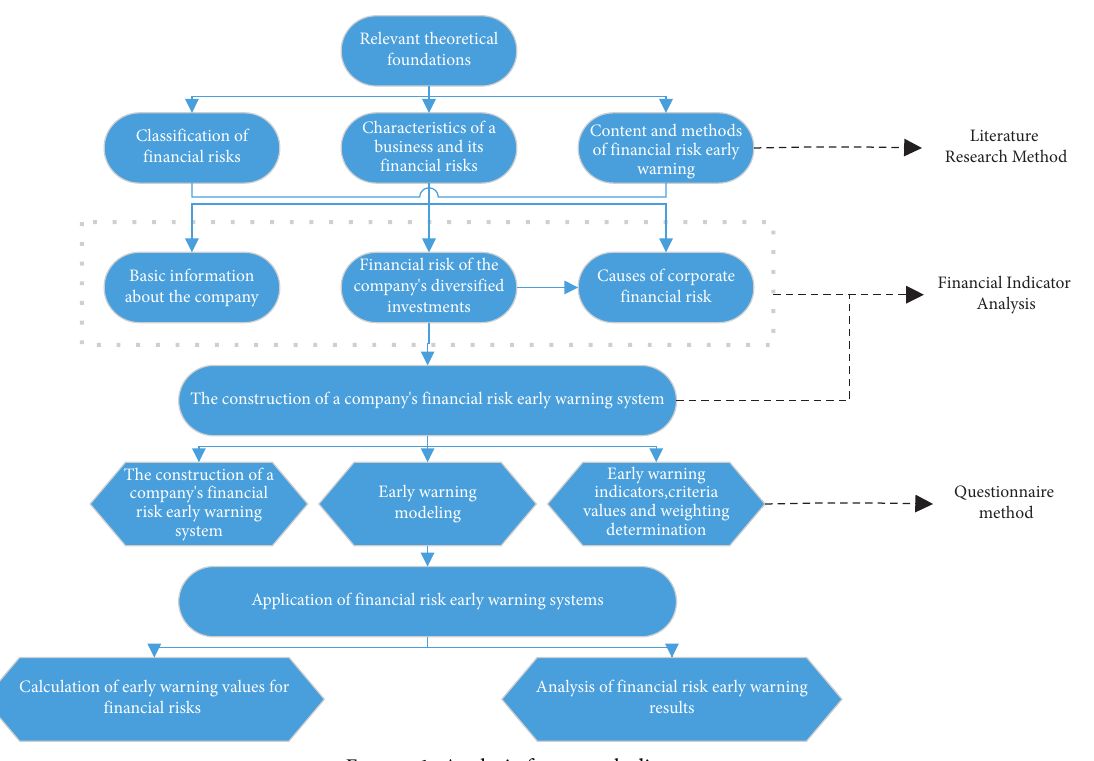
Figure 1: Analysis framework